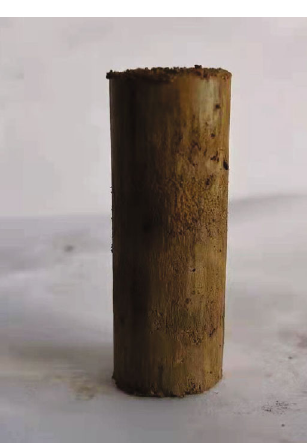
Figure 1: Clay sample